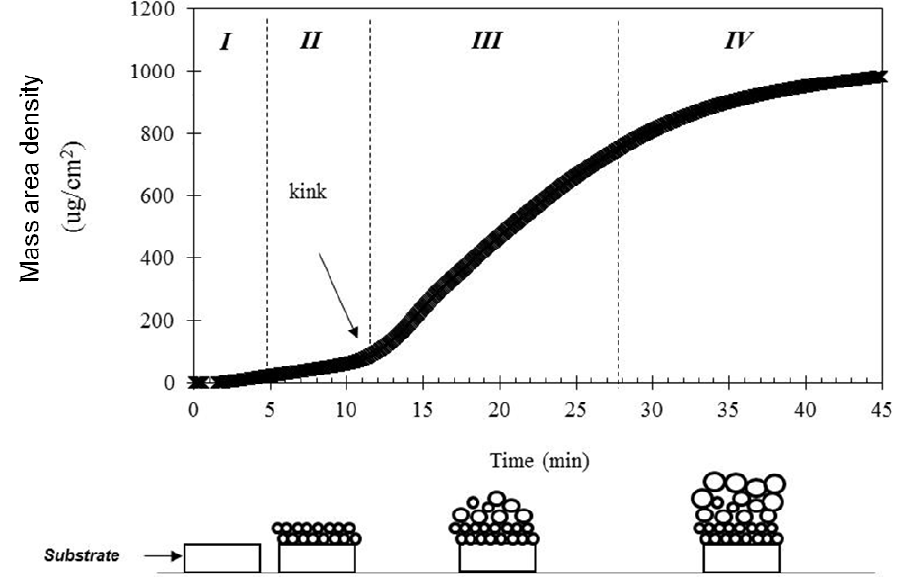
Figure 2. A typical growth curve and the growth mechanism of film prepared by a CBD